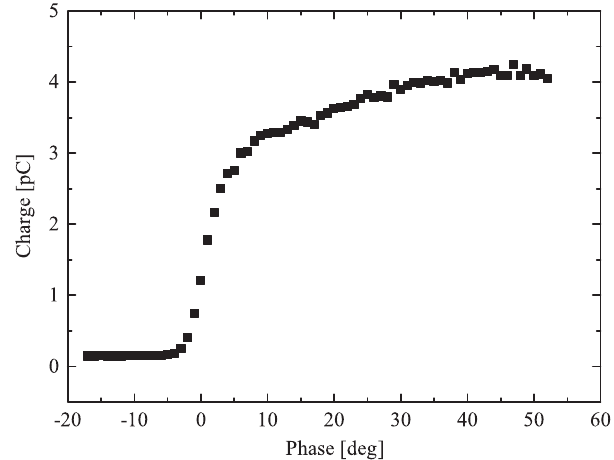
FIG. 3. Extracted charge versus launch phase at a peak field on the cathode surface of 12 MV = m .